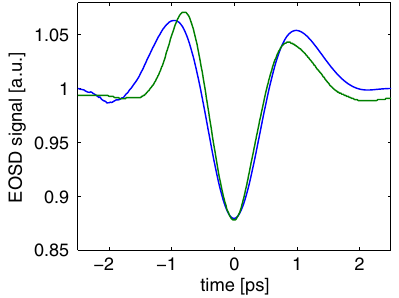
FIG. 12. EOSD measurement (blue) compared to the simula- tion (green) filtered with the transfer function of the IR beam line.